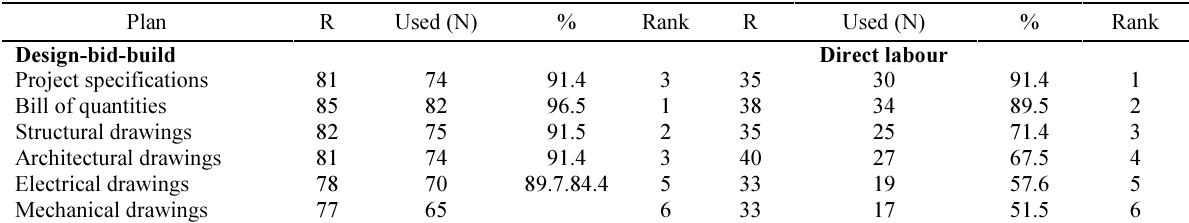
Table 5. Ranking of the levels of use of selected design stage plans in projects procured by DL and DBB methods Plan Design-bid-build Project specifications